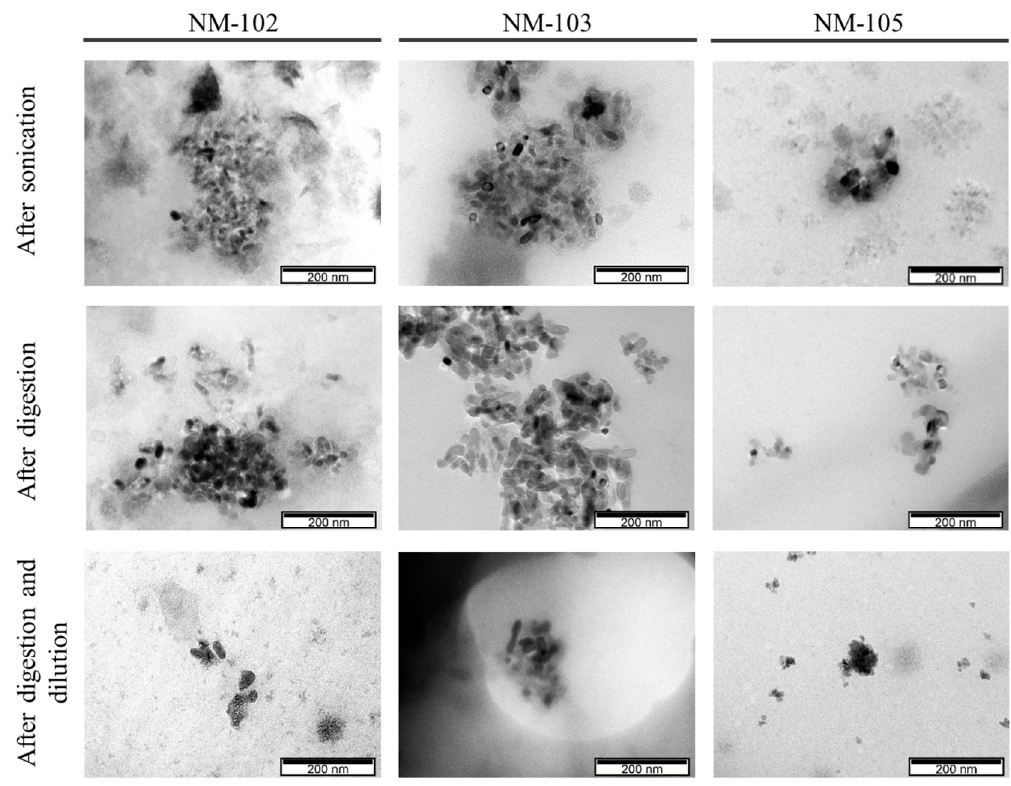
Figure 2. TiO 2 observed under electron microscopy, at a scale of 200